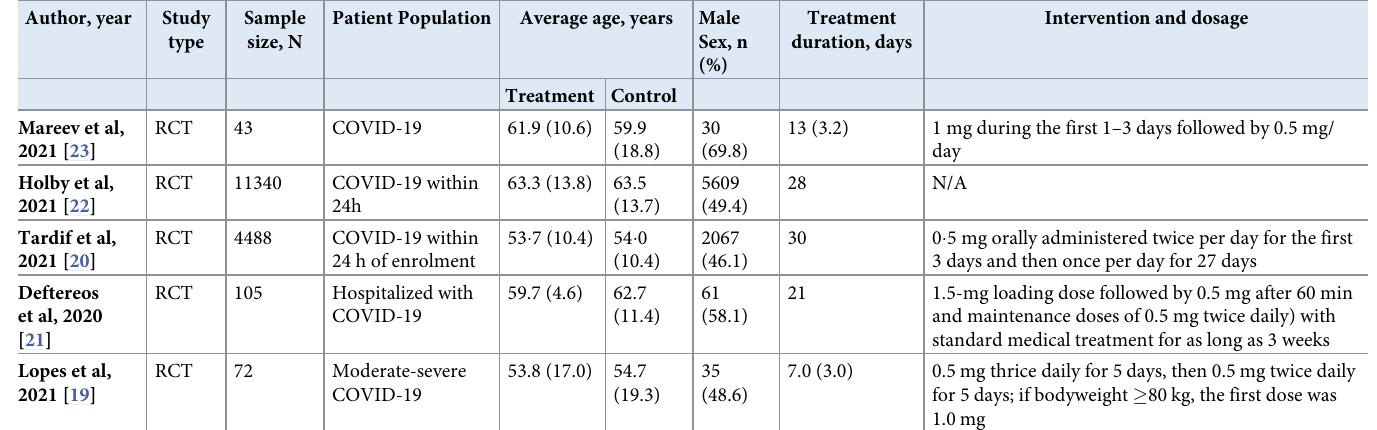
Table 1. Study characteristics of included studies.